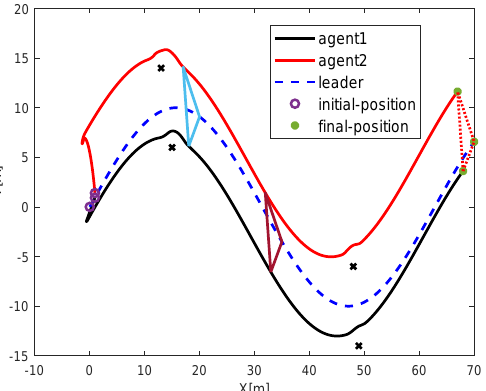
Figure 9. Formation control while considering obstacles (black cross).